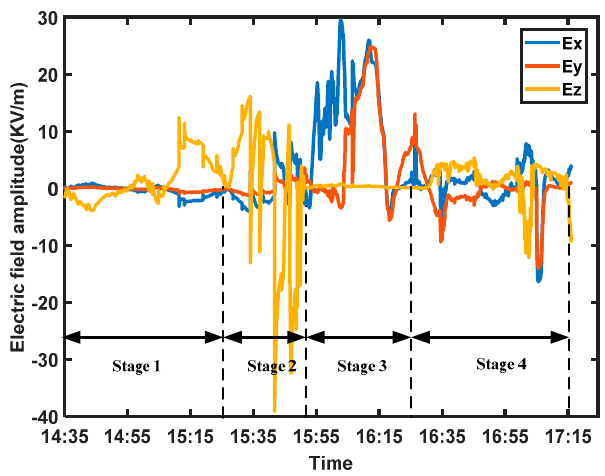
Figure 4. Three-dimensional atmospheric electric field curve.